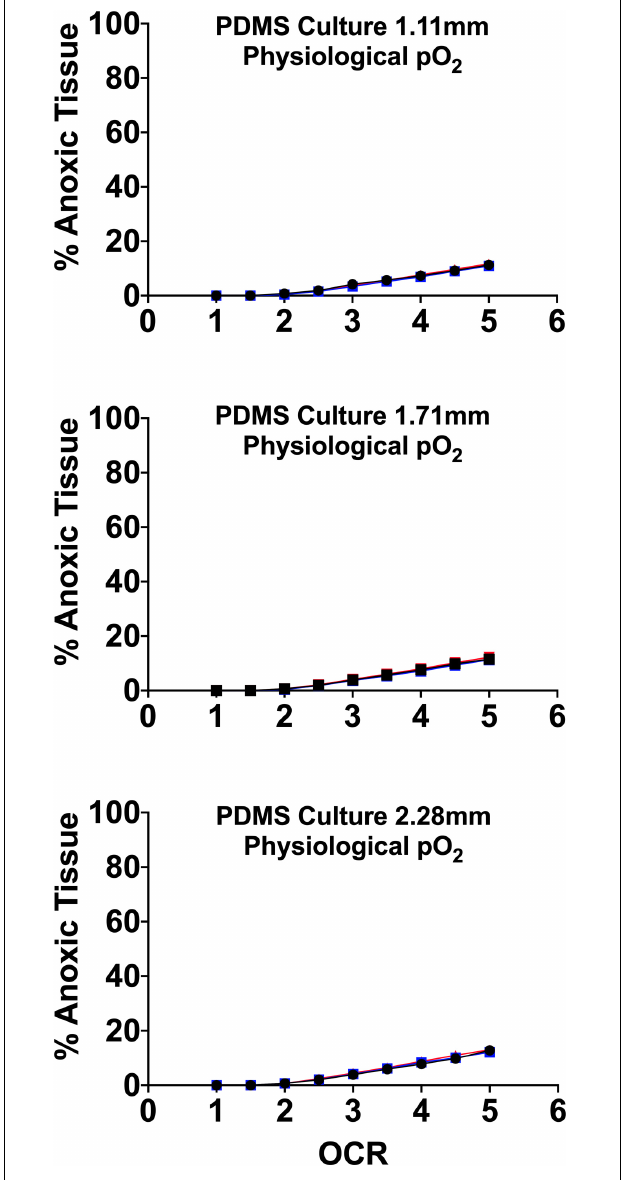
FIGURE 8 | Anoxic tissue volume percentages of endocrine spheroids (representative size range and OCR) cultured on perfluorosilane/PDMS constructs in the presence of physiological pO 2 (95 mmHg). Anoxia is minimal in all but the largest aggregate size at the highest oxygen consumption rates. FEM was performed using three seeding densities (2.76–5.05%) and three culture medium heights (1.11, 1.71, and 2.28